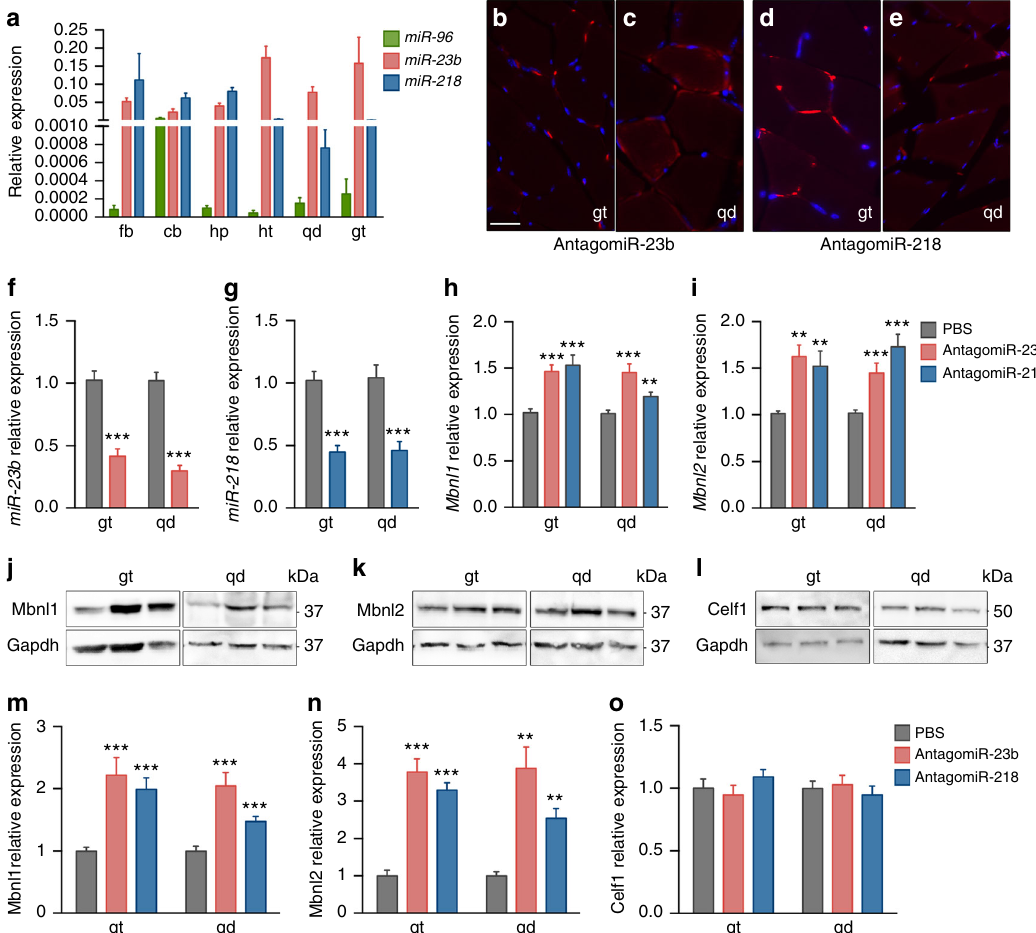
Fig. 5 Subcutaneous injection of antagomiR-23b or antagomiR-218 in HSA LR mice reduced target miRNA levels and increased Mbnl1 and Mbnl2 without affecting levels of Celf1. a qPCR quanti fi cation of miR-96 , miR-23b , and miR-218 expression levels in forebrain (fb), cerebellum (cb), hippocampus (hp), heart (ht), and quadriceps (qd) and gastrocnemius (gt) muscles ( n = 3). Average expression levels of U1 and U6 were used for normalization. b – e Immunodetection of Cy3-labeled antagomiRs in gastrocnemius ( b , d ) and quadriceps ( c , e ) cryosections of HSA LR treated mice ( n = 1). Myonuclei were counterstained with DAPI (blue). Scale bar = 50 μ m. f – g Quanti fi cation of miR-23b and miR-218 in gt and qd muscles of untreated mice (PBS, gray bars) or treated with antagomiR-23b (pink bars) or antagomiR-218 (blue bars). Relative values (to average of U1 and U6 expression) were further normalized to the levels in untreated mice. h, i Real-time PCR quanti fi cation of Mbnl1 and Mbnl2 transcript levels in gt and qd muscles. Expression levels relative to the endogenous Gapdh were normalized to the levels in untreated mice. j – o Western blotting analysis of Mbnl1 ( j , m ), Mbnl2 ( k , n ), and Celf1 ( l , o ) proteins in mouse gt and qd muscles. Representative blots used for quanti fi cation in ( m – o ) are shown in ( j – l ). The data were analyzed by unpaired Student ’ s t test compared to untreated HSA LR mice. Data are mean ± SEM. * p < 0.05, ** p < 0.01, *** p < 0.001; HSA LR PBS ( n = 10 in f – o ), HSA LR antagomiR-23b ( n = 9,